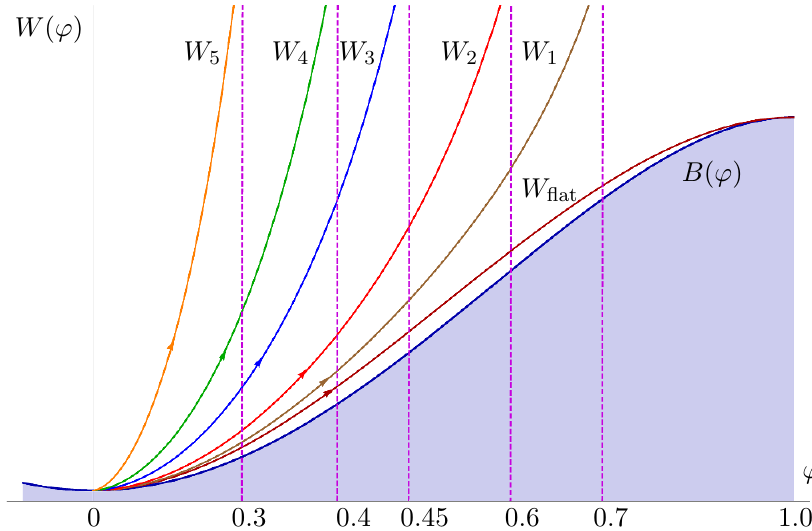
Figure 11. Solutions for W ( ’ ) with R (cid:21) 0 and for the potential (5.1) with (cid:1) (cid:0) = 1 : 2. The (cid:12)ve solutions W i ( ’ ) with i = 1 ; : : : ; 5 di(cid:11)er in the value of their IR endpoint ’ 0 . The critical curve is p de(cid:12)ned as B ( ’ ) = (cid:0) 3 V ( ’ ). In the case of zero and positive curvature, the superpotential W ( ’ ) cannot enter the are below the critical curve, which is depicted as the shaded